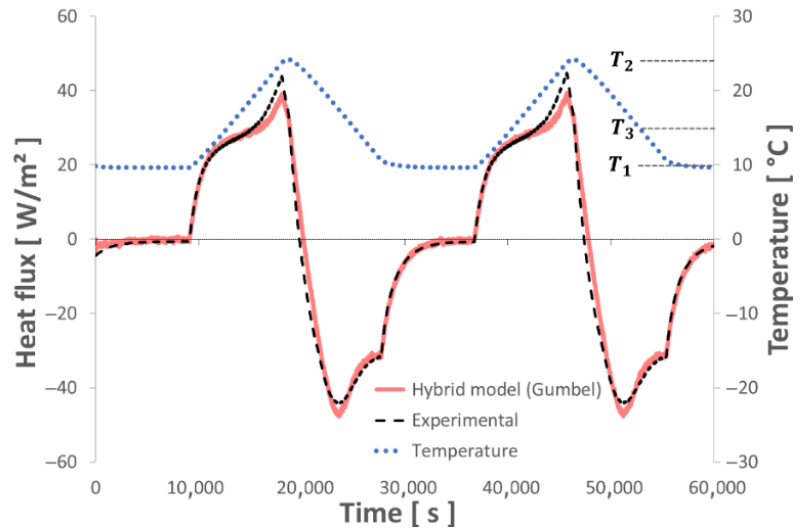
Figure 19. Evolution of the flux exchanged between the plate and the sample (partial melting).